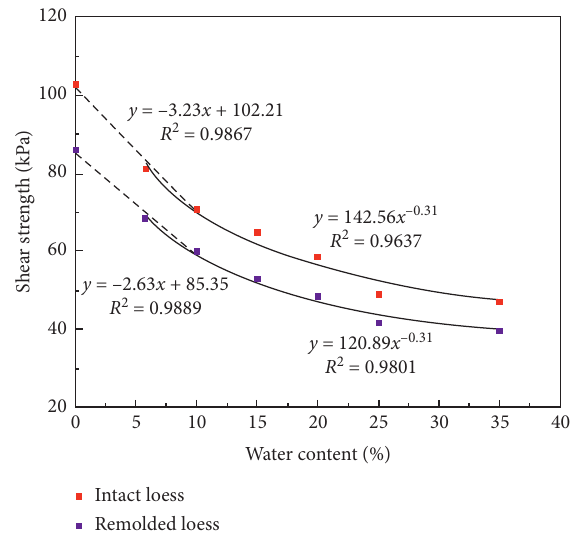
Figure 6: The water content and shear strength diagram of intact, remolded